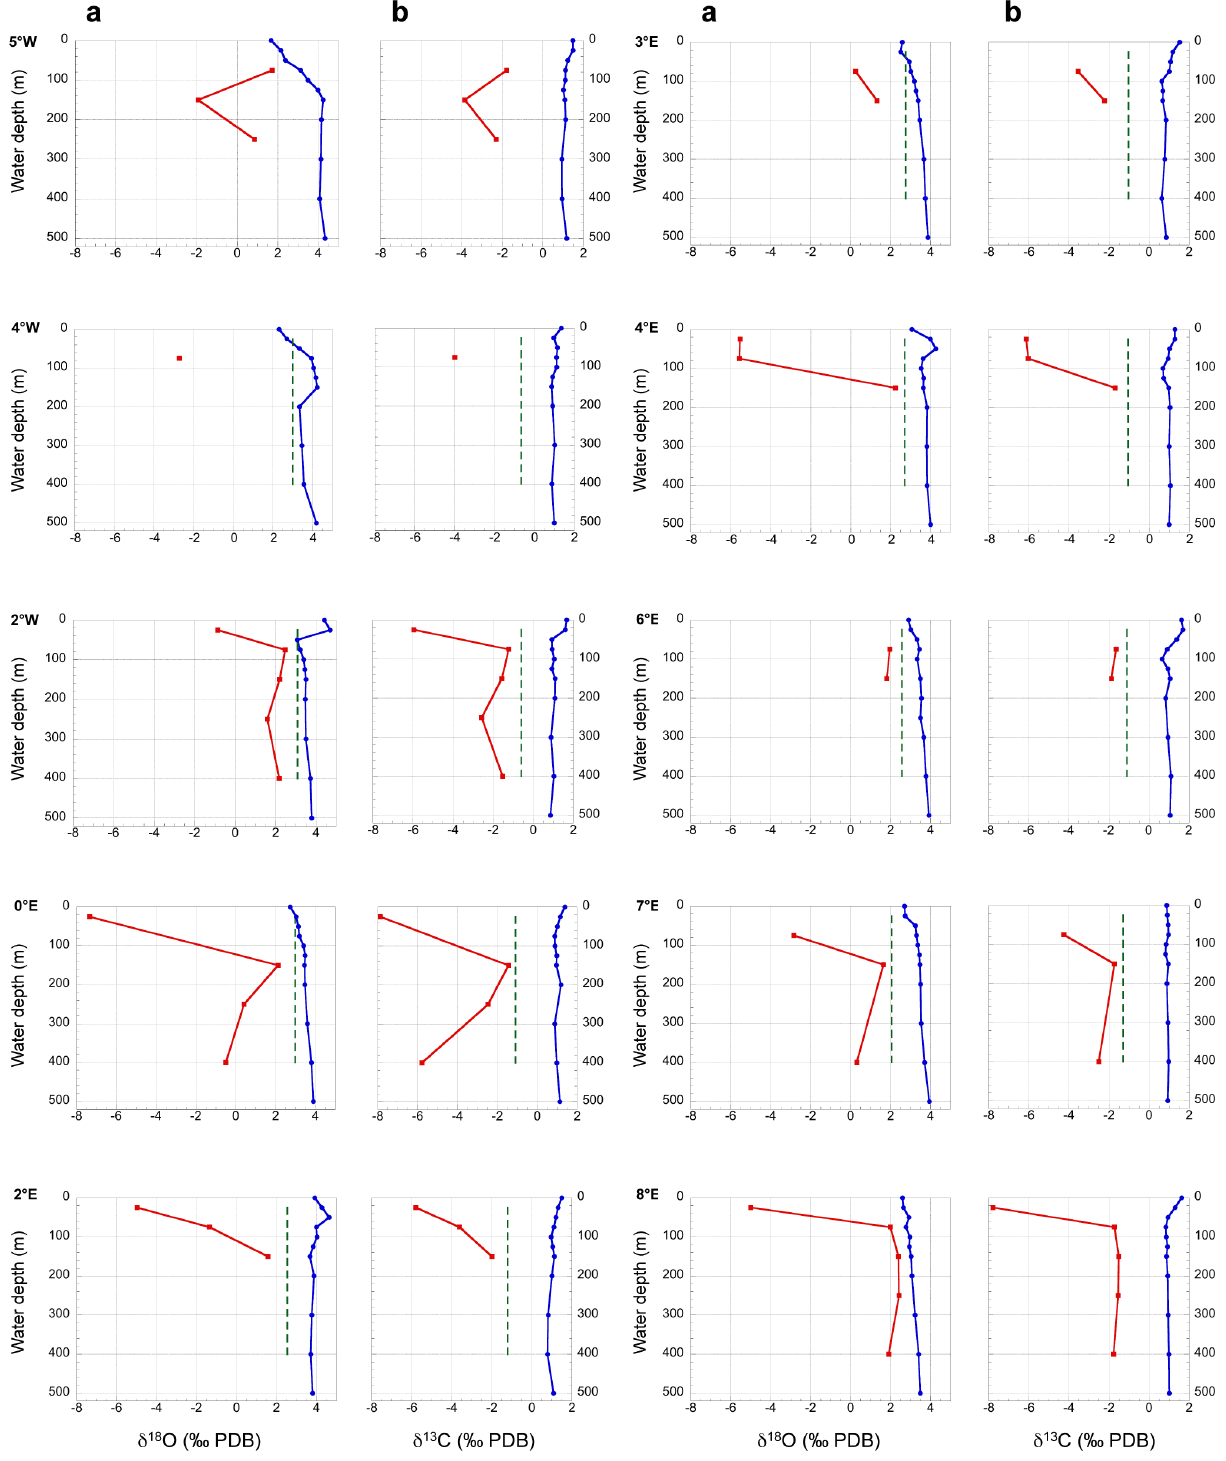
Figure 9. (a) δ 18 O and (b) δ 13 C values of T. quinqueloba from the water column (red squares) and from the sediment surface (green dashed line). The blue dots indicate (a) the equilibrium calcite and (b) the δ 13 C DIC profile of the water